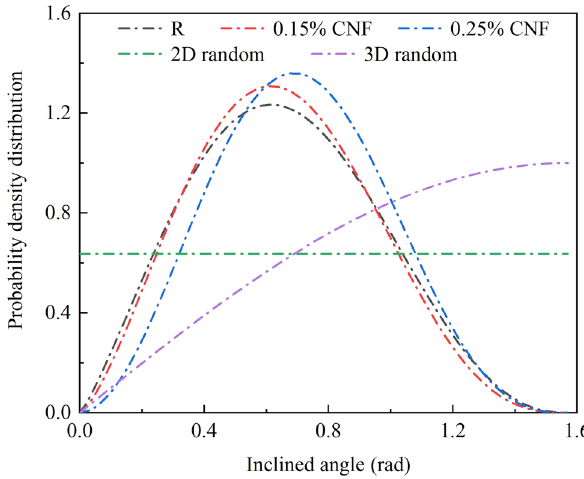
Figure 12: Probability density distribution of steel fi ber inclination. The increase of steel fi ber distribution probability in the inclined angle interval ranging from 0.4 to 0.8 rad indicates that the orienta - tion has been optimized after adding CNF suspensions.